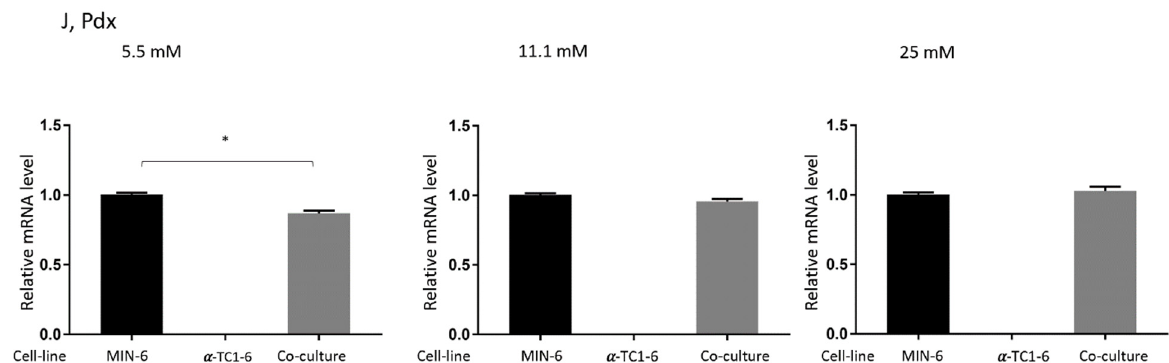
Figure 4. Effects on gene expression in mono- or co-cultured MIN-6 and α -TC1-6 cells after 72 h incubation in 5.5, 11.1, or 25 mM glucose. Transcript abundance of 20 specific genes was assessed by real-time RT-PCR using TaqMan assays; only the results of glucagon (Gcg) are shown here. Ten samples were obtained for each condition, and the samples were measured in quadruplicates. Data are presented as mean ± SEM. * p < 0.05, ** p < 0.01.